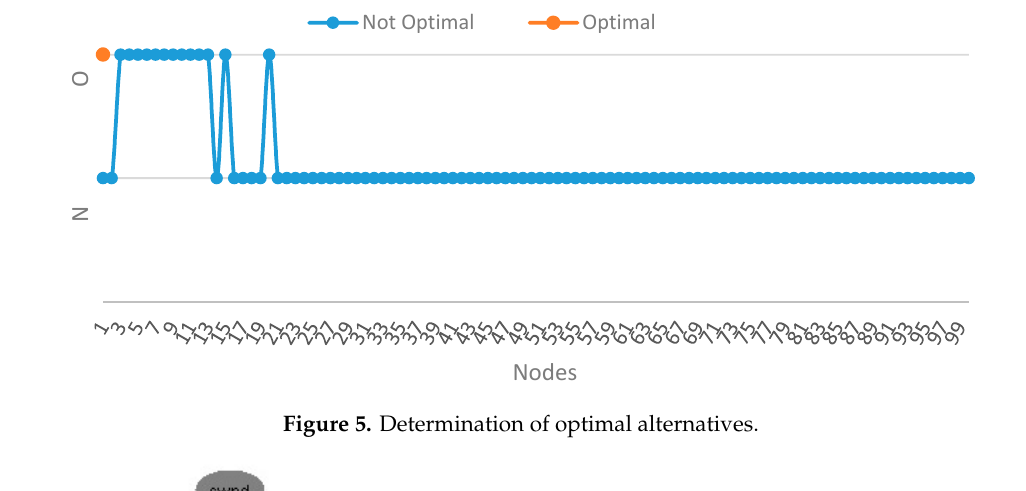
Figure 5. Determination of optimal alternatives.